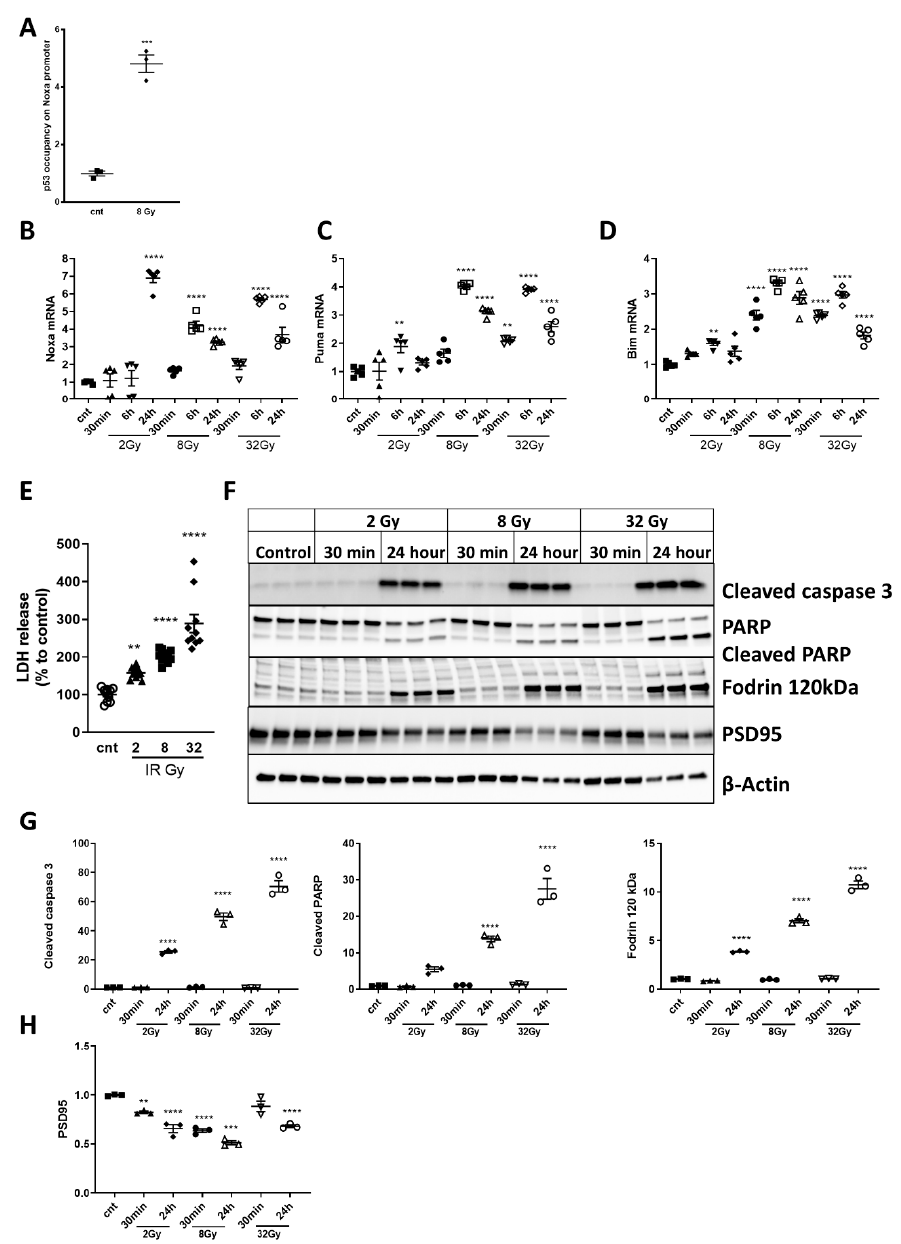
Figure 4. Select pro-apoptotic members of the Bcl-2 family are upregulated in irradiated primary cortical neurons. Post-ChIP qPCR to examine occupancy of p53 on Noxa promoter region ( A ). (T(4) = 2.08, p = 0.0001). Data presented as fold change to non-irradiated control group. n = 3 / group. Significance assigned based on one-tailed t-test, *** p < 0.001 versus control Rat primary cortical neurons (RCNs). qPCR quantification of Noxa ( B ) (F(9,40) = 63.76, p < 0.0001 for 24 h 2Gy and for 6 h and 24 h 8 and 32Gy, compared to control), Puma ( C ) (F(9,40) = 56.47, p = 0.0051 for 6 h 2Gy, p = 0.0002 for 30 min 32Gy, and p < 0.0001 for 6 and 24 h 8Gy and 32Gy, compared to control), Bim ( D ) (F(9,40) = 65.12, p = 0.0044 for 6 h 2Gy, p < 0.0001 for all-time points treated with 8 and 32Gy except 30 min 8Gy, compared to control). Data presented as